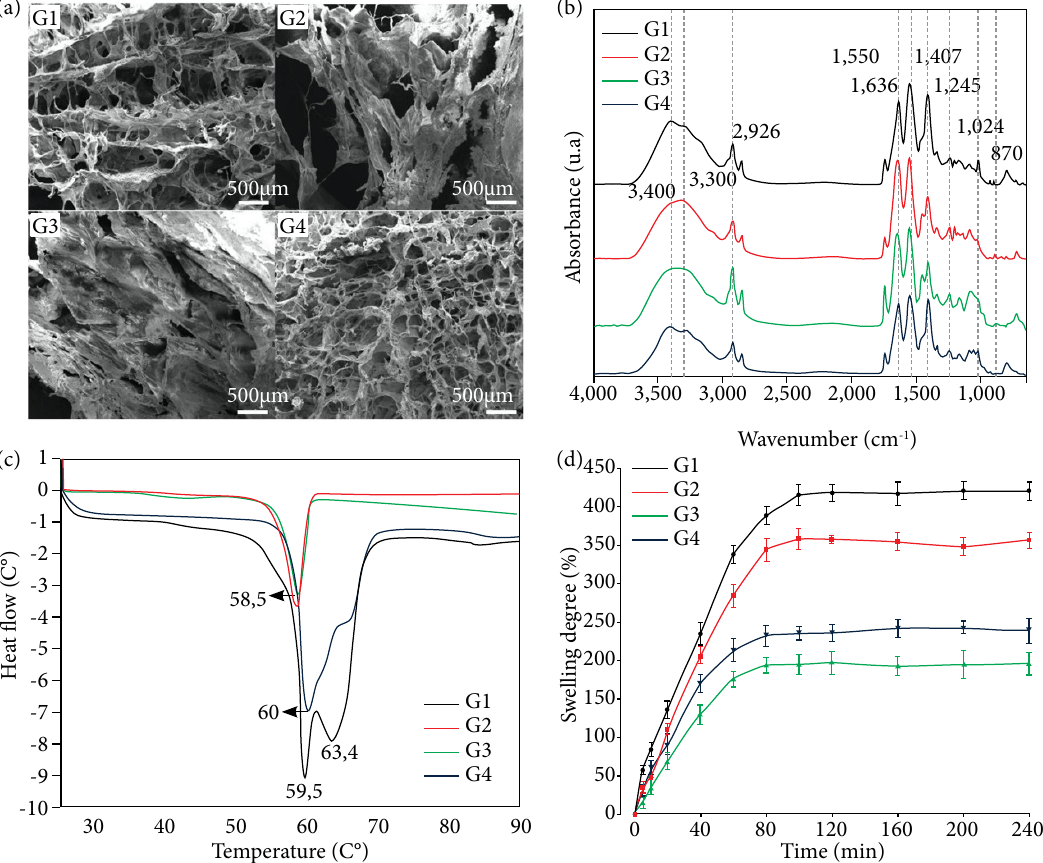
Figure 2 - Physicochemical analysis of poultry collagen-based hydrogels: (a) scanning electron microscope; (b) Fourier-transform infrared spectroscopy; (c) differential scanning calorimetry; (d) swelling